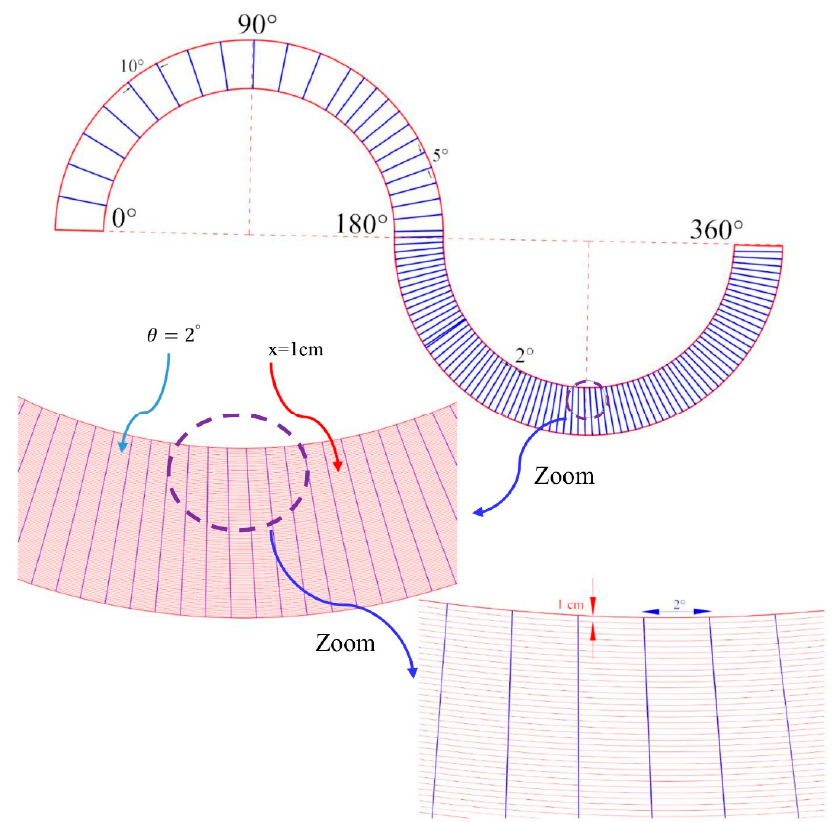
Figure 2. An instance of the mesh grid for data collection in mean velocity-to-critical velocity ratio (U/Uc) = 0.98